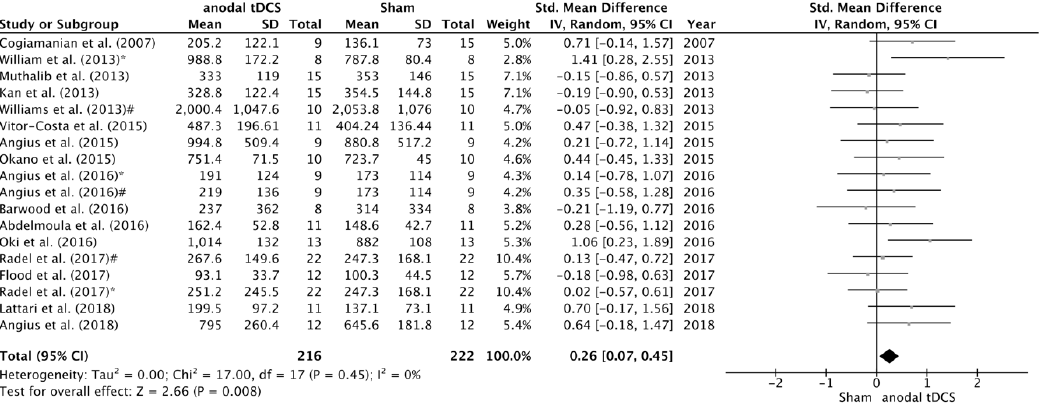
Figure 3. Forest plot of the comparison of TTF between anodal tDCS and sham conditions. Williams